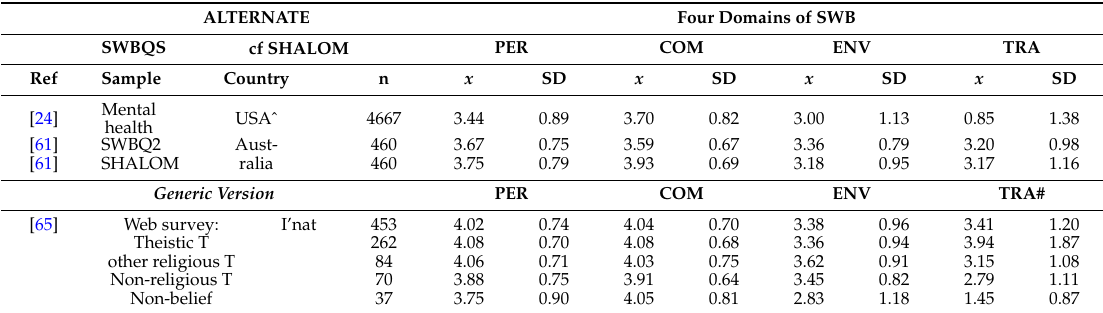
Table 2. Alternate versions of the SWBQ-SHALOM used to assess